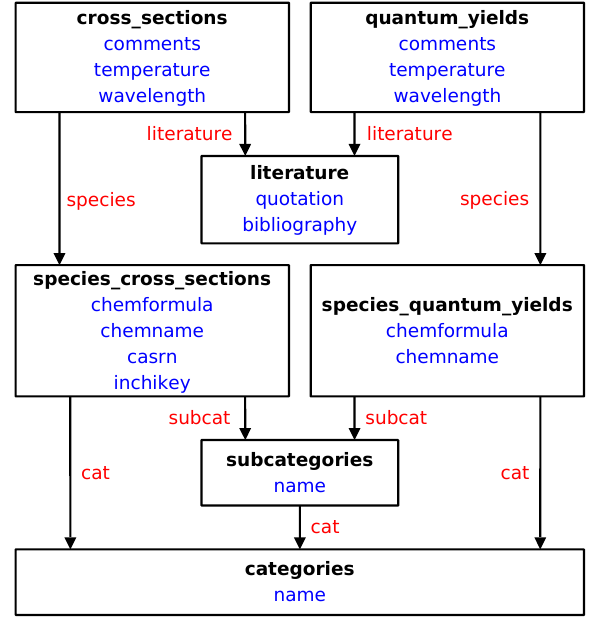
Figure 3. Structure of the PostgreSQL database. Black = table names; blue = table columns; and red = foreign keys pointing to other